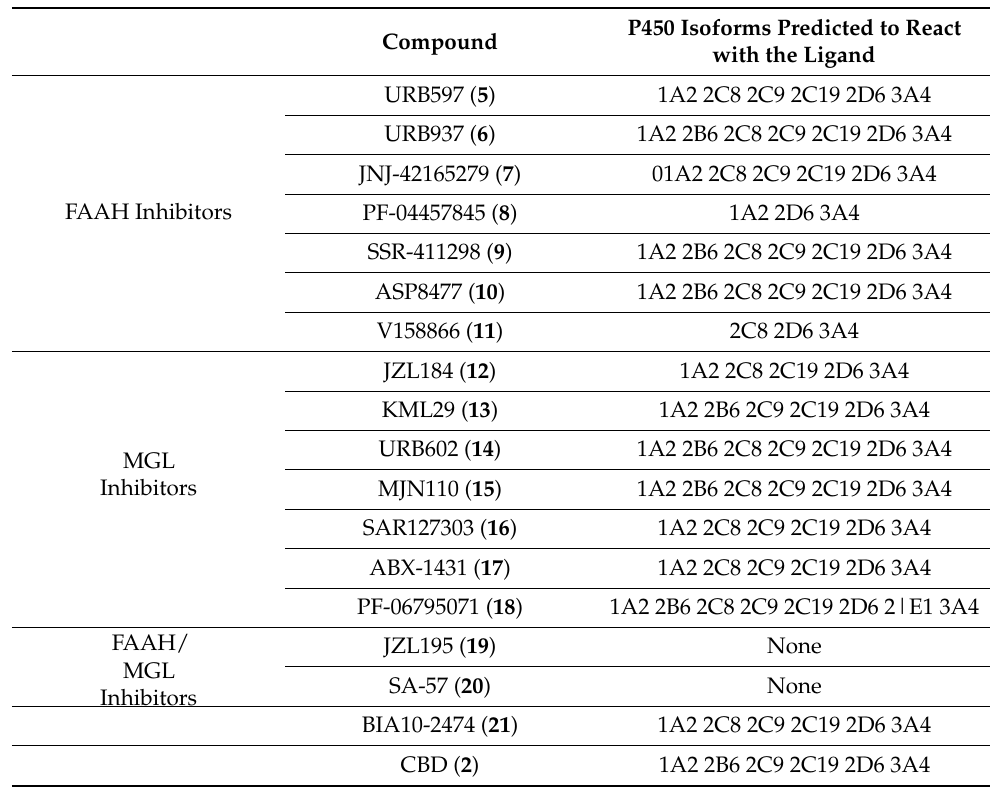
Table 3. Metabolic liability is predicted for all the investigated compounds. The prediction is performed using as software program CypReact. P450 Isoforms Predicted to React Compound with the